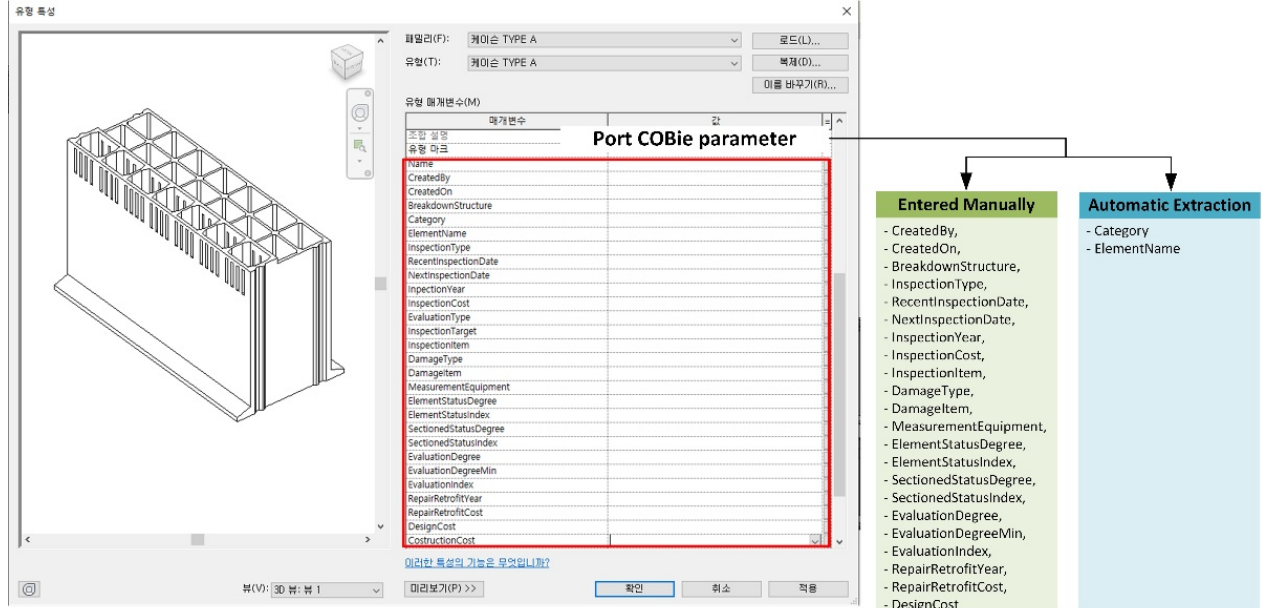
Figure 11. The process of Dynamo modeling for port COBie system.